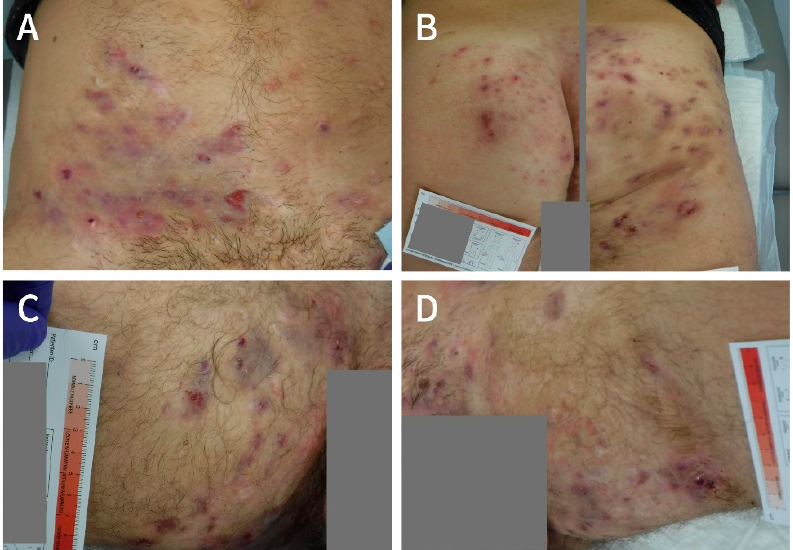
Figure 1. Manifestations of Hidradenitis suppurative (HS) in the mons pubis area and lower abdomen ( A ), buttocks ( B ), right thigh ( C ) and left thigh ( D ) at the beginning of LAight therapy (July